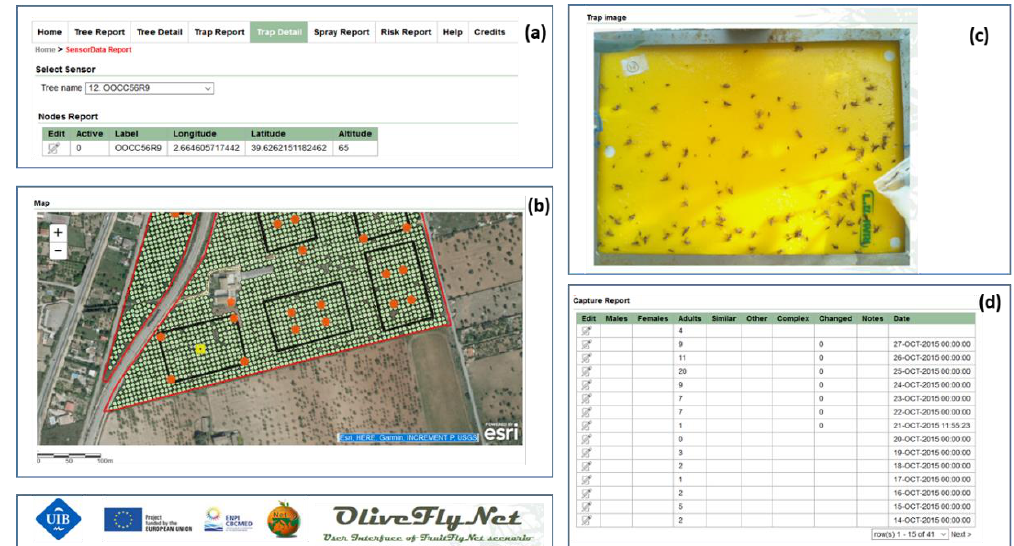
Figure 7. Output of the OliveFlyNet application interface showing details about the real-time insect counting system (ReTIC) system based on analysis of pictures sent by the e-traps. ( a ) Node report, ( b ) Node location, ( c ) Trap image, and ( d ) Capture report.